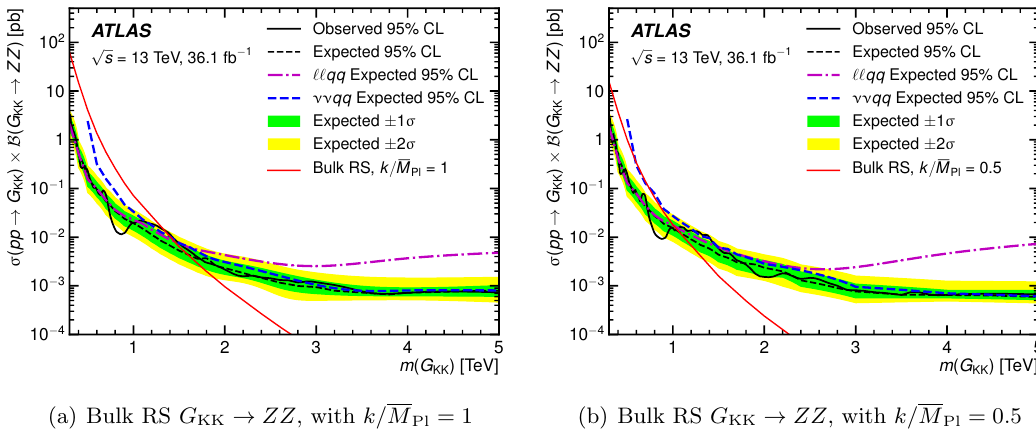
Figure 14 . Observed (black solid curve) and expected (black dashed curve) 95% CL upper limits on (cid:27) ( G KK ZZ ) at p s = 13 TeV for the production of a G KK in the bulk RS model with (cid:2) B ! couplings of (a) k=M Pl = 1 and (b) k=M Pl = 0 : 5 as a function of the graviton mass, combining ‘‘qq and (cid:23)(cid:23)qq searches. Limits expected from individual searches (dashed curves in blue and magenta) are also shown for comparison. Limits are calculated in the asymptotic approximation below 2 TeV and are obtained from pseudo-experiments above that. The theoretical predictions for (cid:27) ( G KK ZZ ) as a function of resonance mass for a bulk RS graviton are also shown. The green (cid:2)B ! (inner) and yellow (outer) bands represent the 1 (cid:27) and 2 (cid:27) uncertainty in the expected limits. (cid:6) (cid:6)